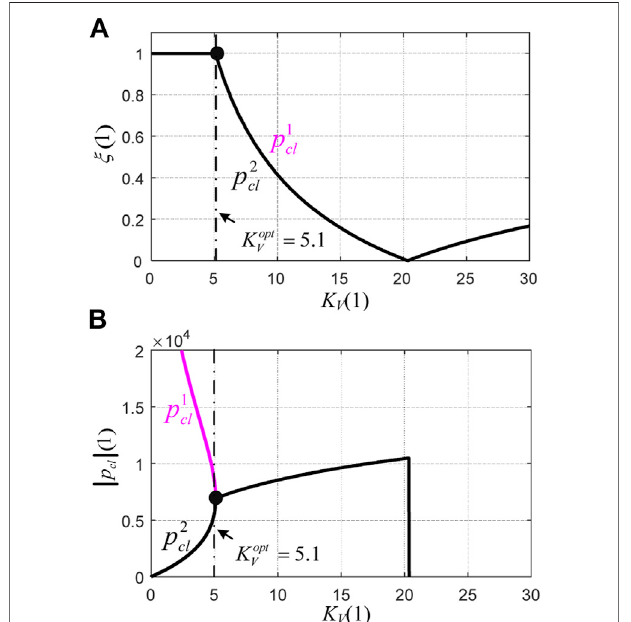
FIGURE 11 | Curve of (A) Kv vs ξ and (B) Kv vs | p | .